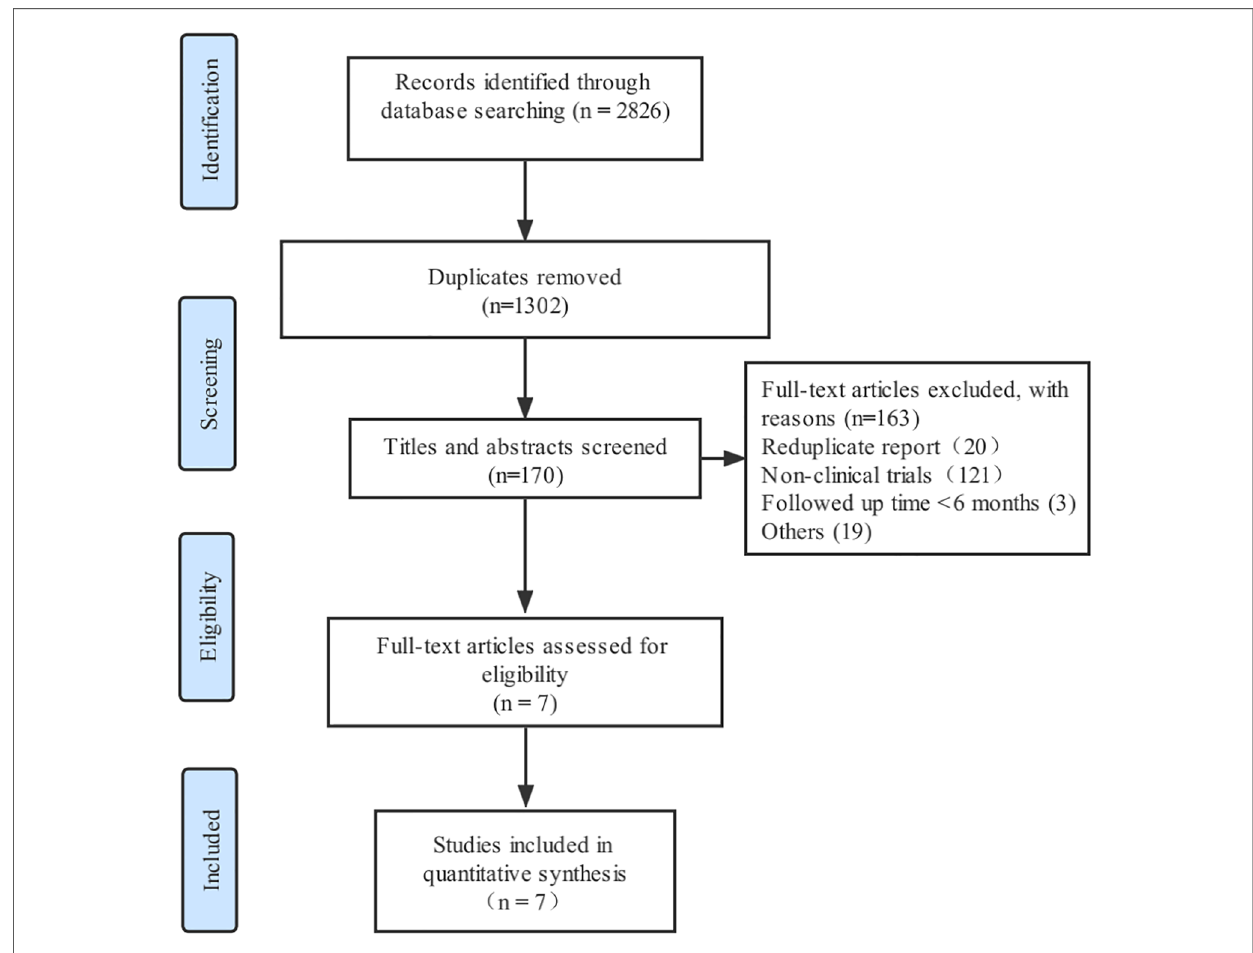
FIGURE 1 Flow diagram of literature